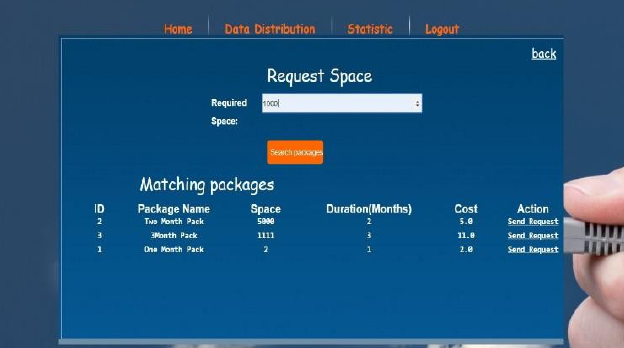
Figure 5. Customer Resource Request